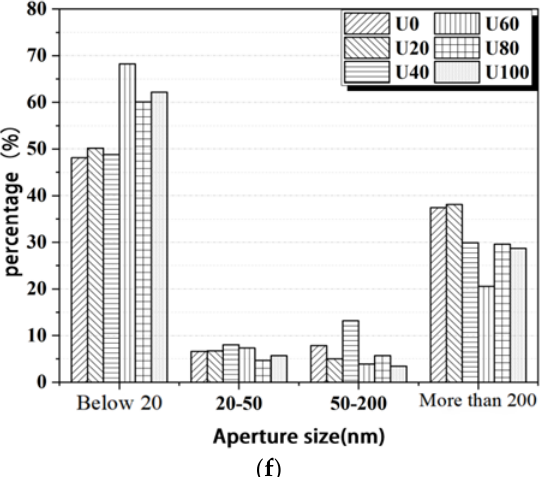
Figure 14. Pore structure of UHPC with different Yellow River sand content after 7 and 28 days of curing: ( a ) cumulative intrusion of 7–day test samples; ( b ) incremental intrusion of 7–day test samples; ( c ) proportion of pores of all sizes in 7–day test samples; ( d ) cumulative intrusion of 28–day test samples; ( e ) incremental intrusion of 28–day test samples; and ( f ) proportion of pores of all sizes in 28-day test samples.